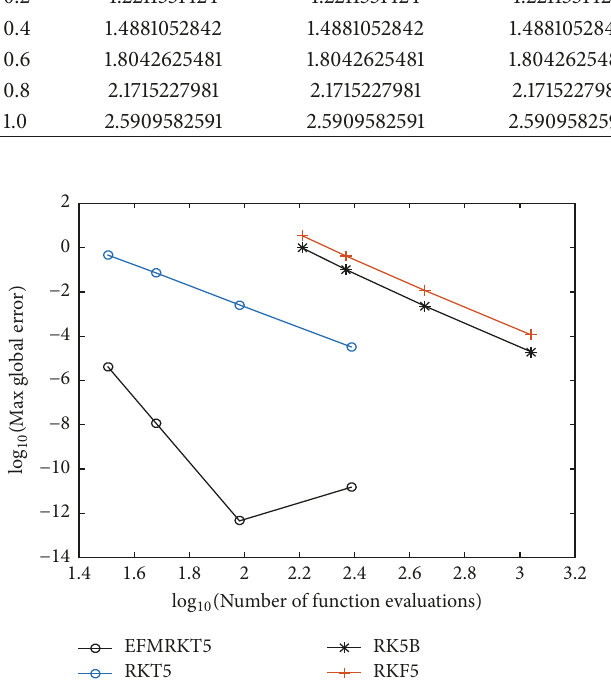
Figure 3: The efficiency curve for EFMRKT5, RKT5, RK5B, and RKF5 for Problem 4 with 𝑥 𝑒𝑛𝑑 = 6 and ℎ = 0.1, 0.25, 0.5, 0.75 .